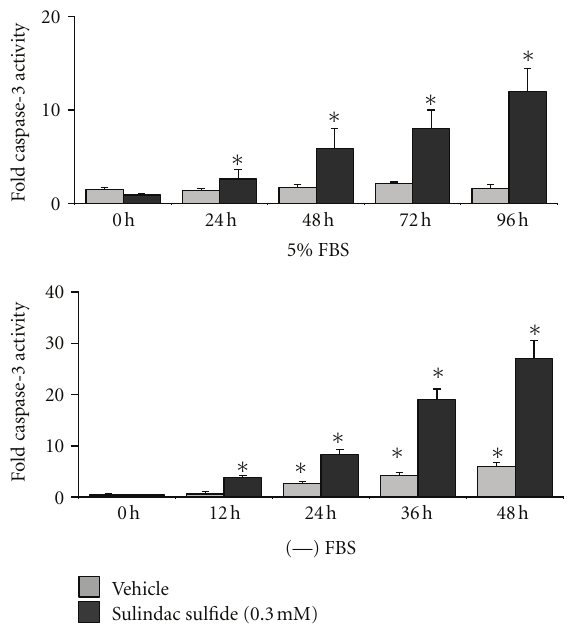
Figure 1: Sulindac sulfide-induced apoptosis is enhanced in serum- free media versus serum-containing media. Equal numbers of HT- 29 cells were plated in each well of 6-well plates, allowed to attach overnight, and then incubated in serum-free media and media containing 5% FBS overnight before treatments with vehicle and sulindac sulfide for the indicated durations. Fold apoptosis is determined by measuring caspase-3 activity in total cell lysates. ∗ Indicates significant increase in fold apoptosis relative to 0 hour timepoint, P < 0 .